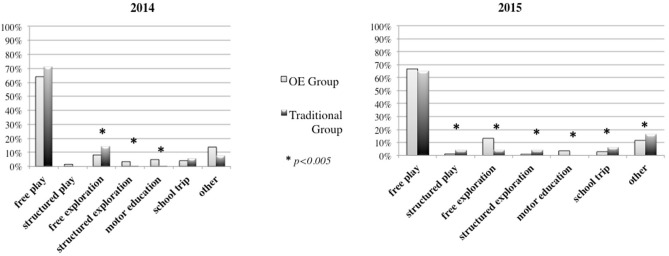
Types of outdoor activities in 2014 and 2015.